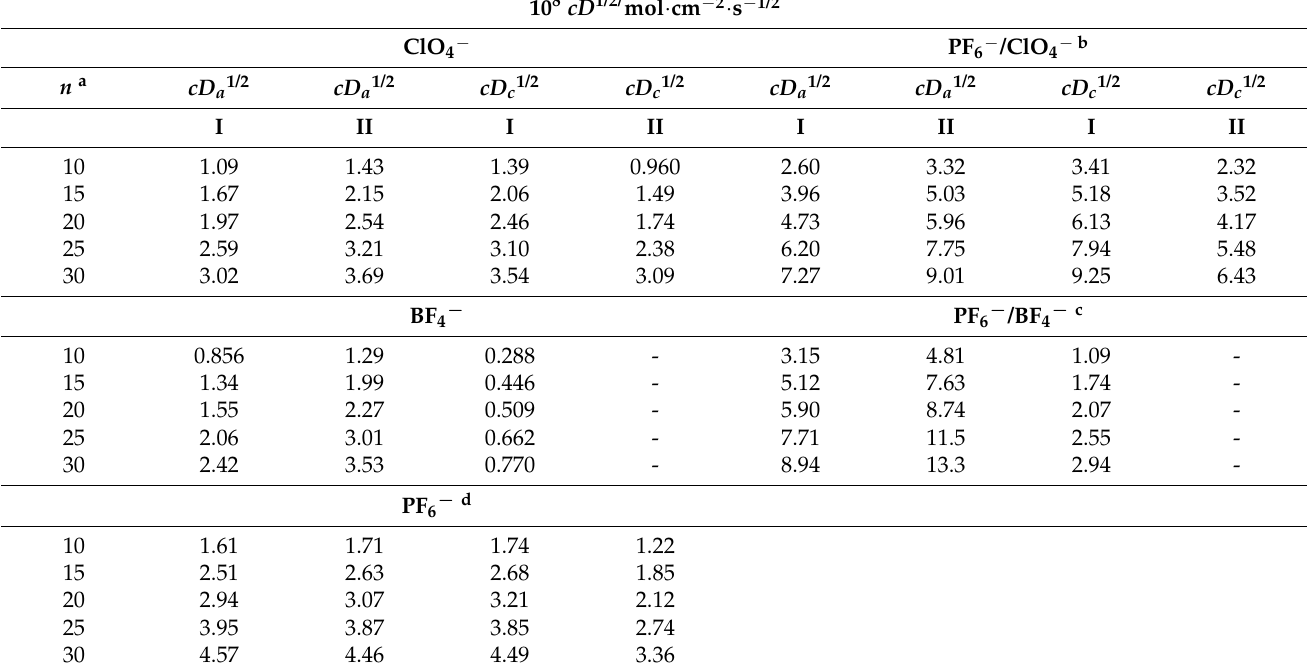
Table 5. Kinetic data for poly [Ni(salcn(Bu))] in various electrolyte solutions (10 − 1 mol · dm − 3 ) in CH 2 Cl 2